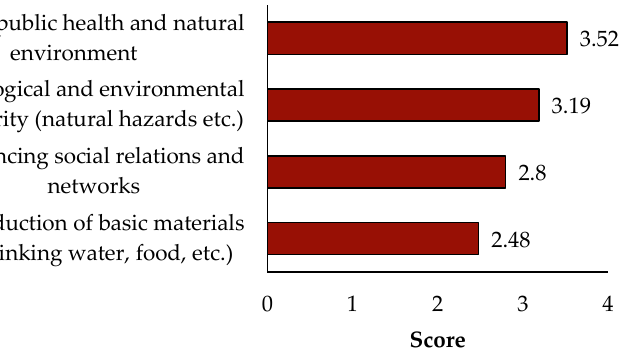
Figure 5. Average scores for assessing UGA importance for specific benefits using a 4 ‐ degree scale.